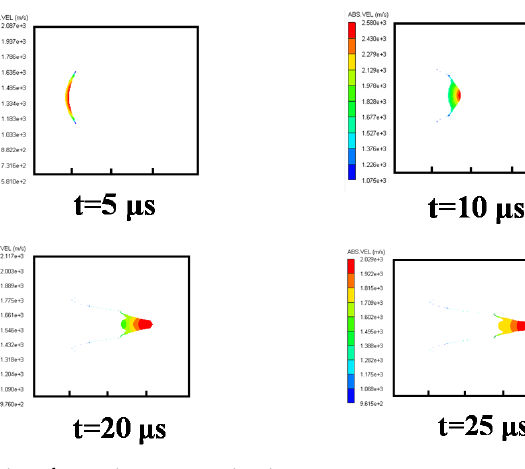
Figure 7. Velocity distribution of EFPs in a formation process in air.